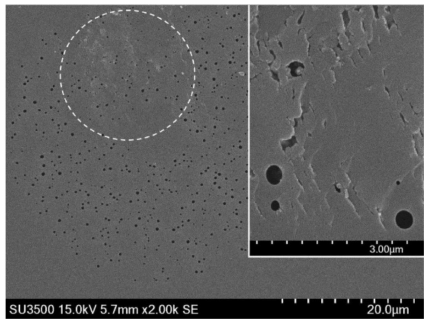
Figure 11. RALF structure and nanogratings inside the FBG in the insert (reproduced from